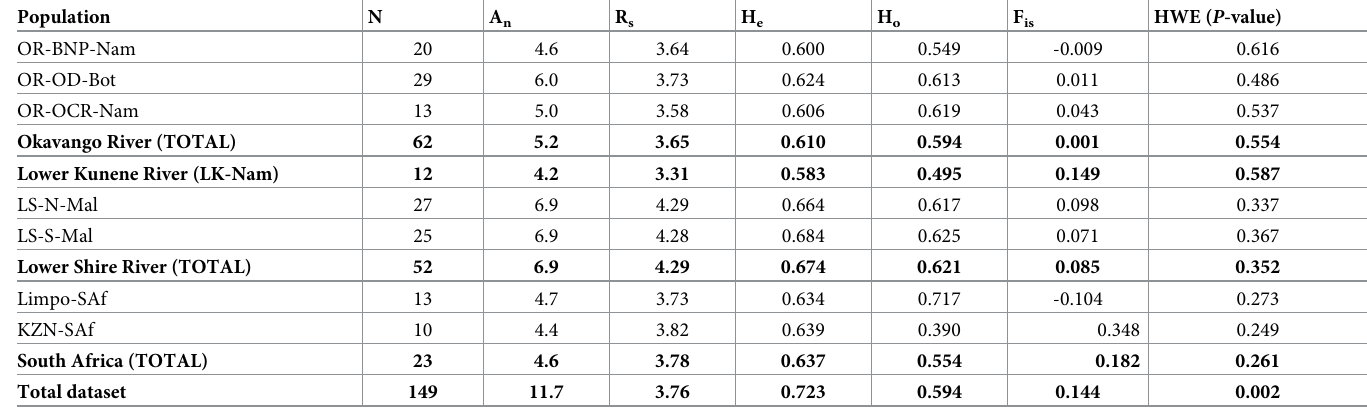
Table 1. Summary of genetic diversity measures and test for Hardy-Weinberg Equilibrium (HWE) in southern African Nile crocodile populations. OR-BNP-Nam: Okavango River system—Bwabwata National Park–Namibia, OR-OD-Bot: Okavango River system—Okavango Delta—Botswana, OR-OCR-Nam—Okavango Crocodile Ranch—Okavango River—Namibia, LK-Nam–Lower Kunene River—Namibia, LS-N-Mal–Lower Shire River (North)—Malawi, LS-S-Mal–Lower Shire River (South)— Malawi, and Limpo-SAf–Limpopo River—South Africa, KZN-SAf–KwaZulu-Natal—South Africa. N—number of individuals, A n —number of alleles, R s —mean allelic richness, H e —expected heterozygosity, H o —observed heterozygosity, and F IS —mean fixation index. Values were estimated based on genotypes determined using 11 nuclear microsatellite markers and averaged across all loci.